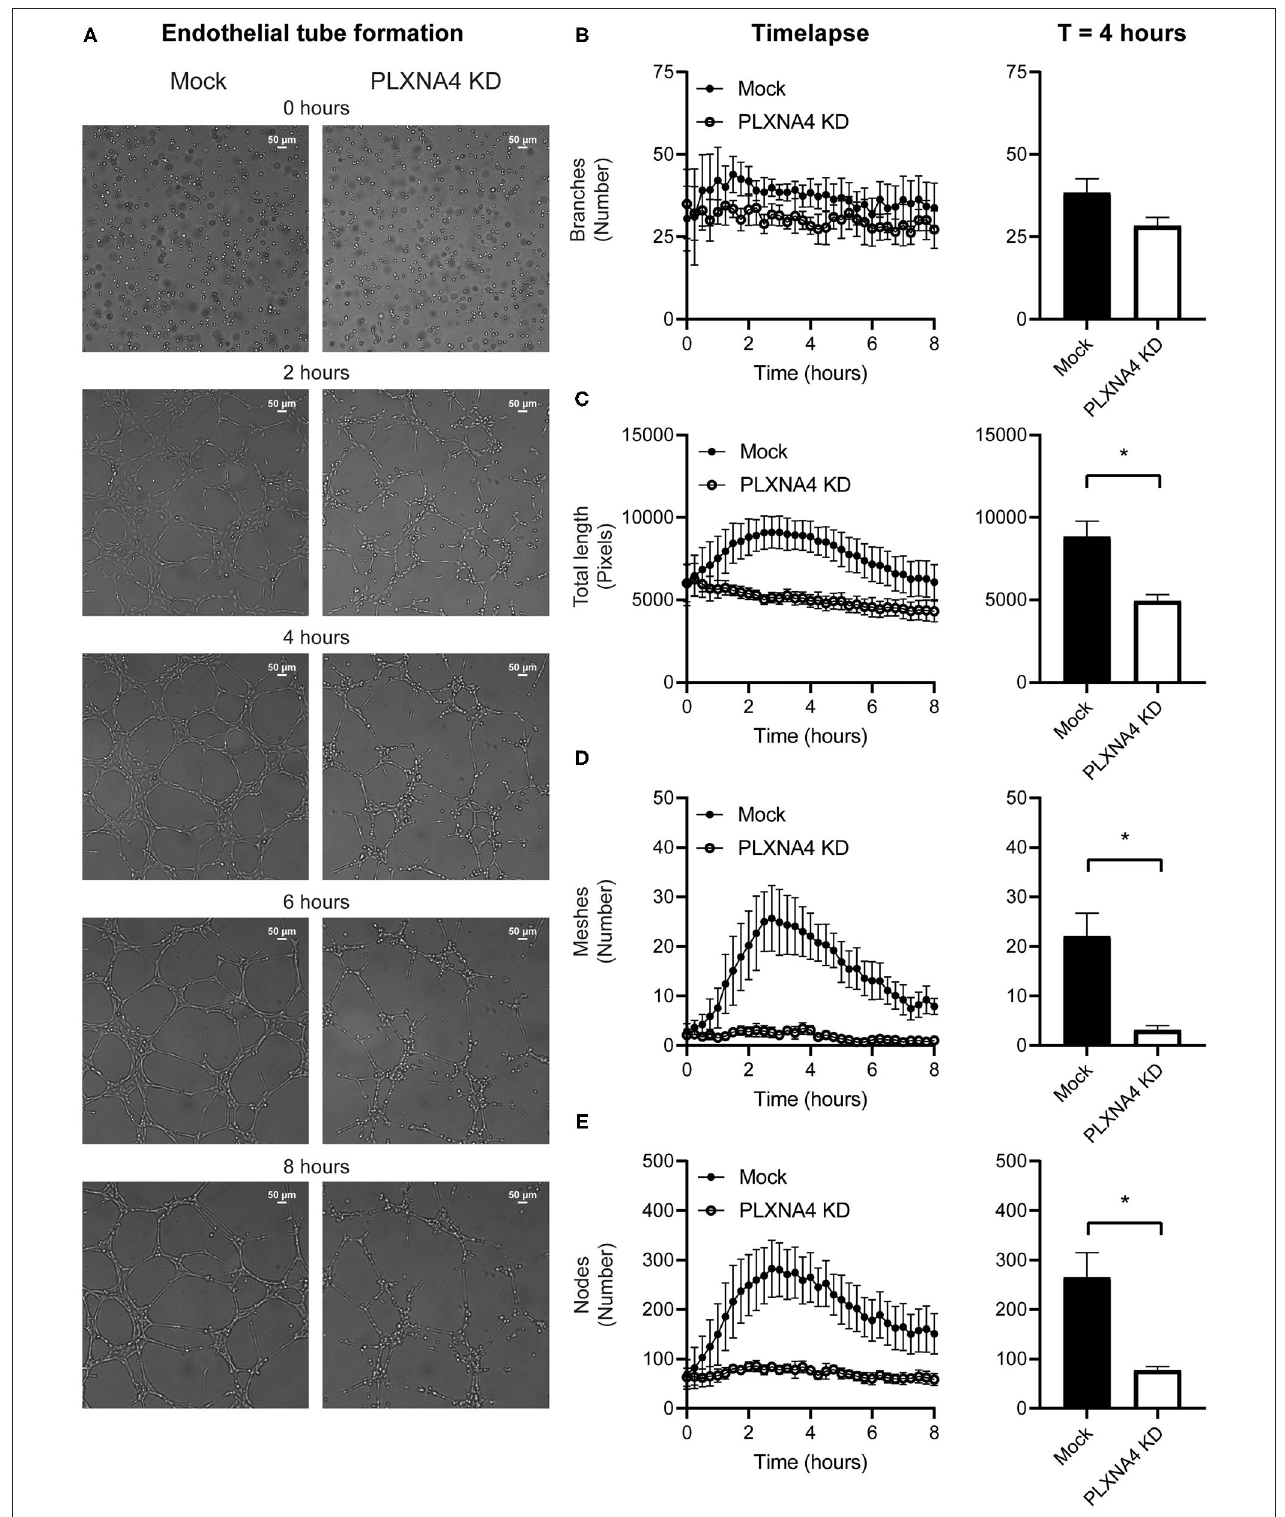
FIGURE 4 | Loss of endothelial PLXNA4 reduces tube-like structure formation. (A) Representative overview photographs and (B–E) quantification of tube formation of mock and PLXNA4 KD endothelial cells over time. Results are presented as (B) number of branches, (C) total length in pixels, (D) number of meshes and (E) number of nodes over time (left graph) and at 4h (right graph). Mean ± S.E.M. of N = 3, * P < 0.05.